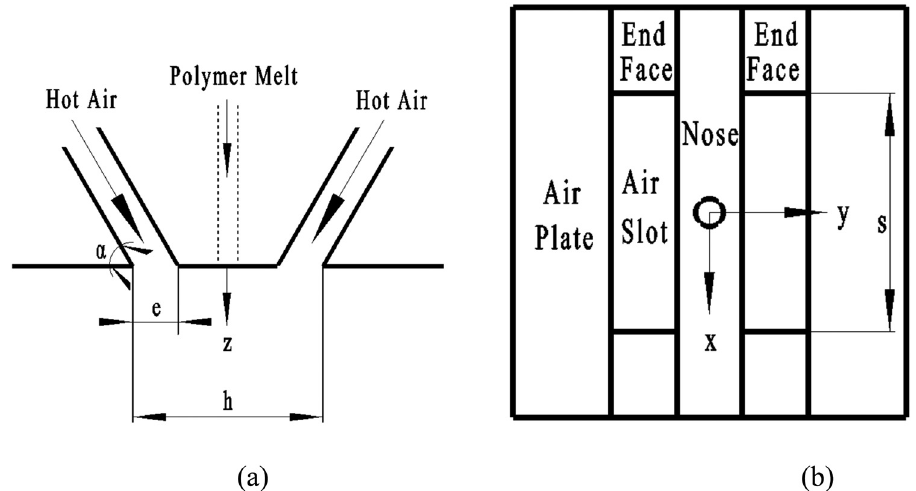
Figure 1: A common slot die: ( a ) section view; ( b ) view of die